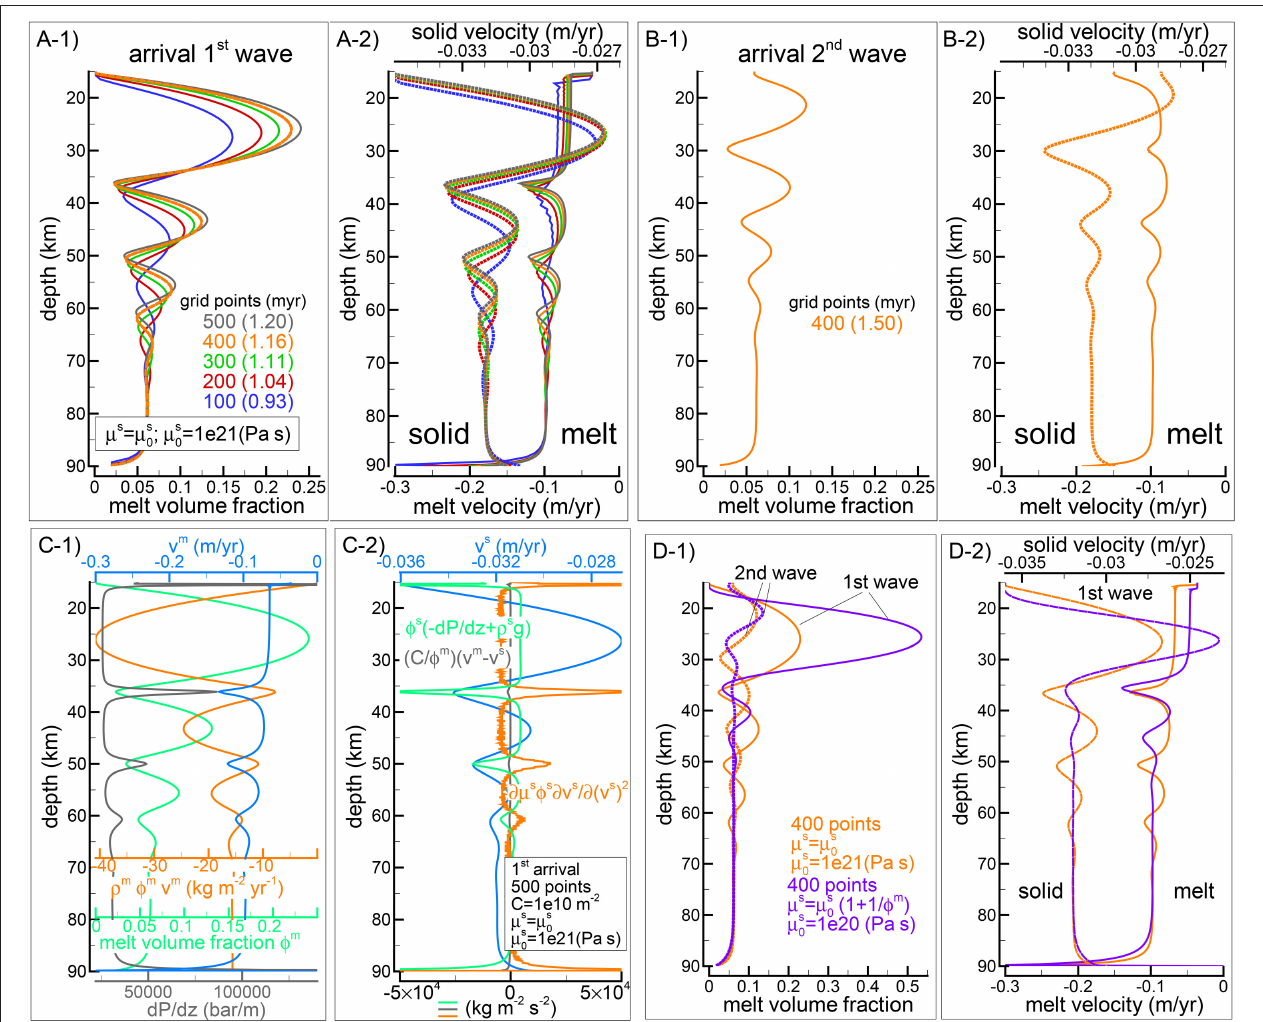
FIGURE 2 | Dynamic two-phase flow model without thermodynamics. (A-1,A-2) Describe the melt volume fraction, melt (solid lines) and solid (dotted lines) vertical velocities when the first melt-wave arrives at the top side of the model. Different colors refer to simulation using different number of spatial grid points (100, 200, 300, 400, 500). Time step is set to 250 years except for the case indicated by the dashed green line ( 1 t = 500 years ). All the simulations assume µ s = µ s 0 , the viscosity of the solid is set to µ s 0 = 1 e 21 Pa s. (B-1,B-2) Show the same simulation with 400 grid points when the second melt-wave arrives at the top side. The dashed lines in panel (A–1) (barely noticeable) show the result using only the MacCormack method for the melt transport. (C-1,C-2) Summarizes some key quantities related to the simulation with 500 spatial grid points at the arrival of the first melt wave (see main text for additional information). A movie for this model is available following the instructions in the Supplementary Material (movie file mf1-movie1.PHASE33B.YRC5.avi ). (D) Comparison of the first and second wave arrival at the top between the previous simulation with µ s = µ s 0 = 1 e 21 Pa s and the one with the alternative viscosity model, µ s = µ s 0 (1 + 1 /φ m ), µ s 0 = 1 e 20 Pa s (400 grid points for both